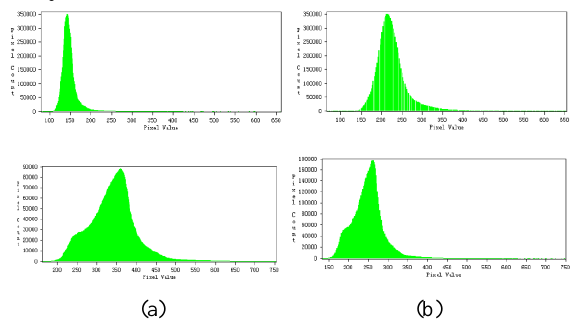
Figure 4 (a) adjacent image histogram before the adjustment (b) adjacent image histogram after the adjustment